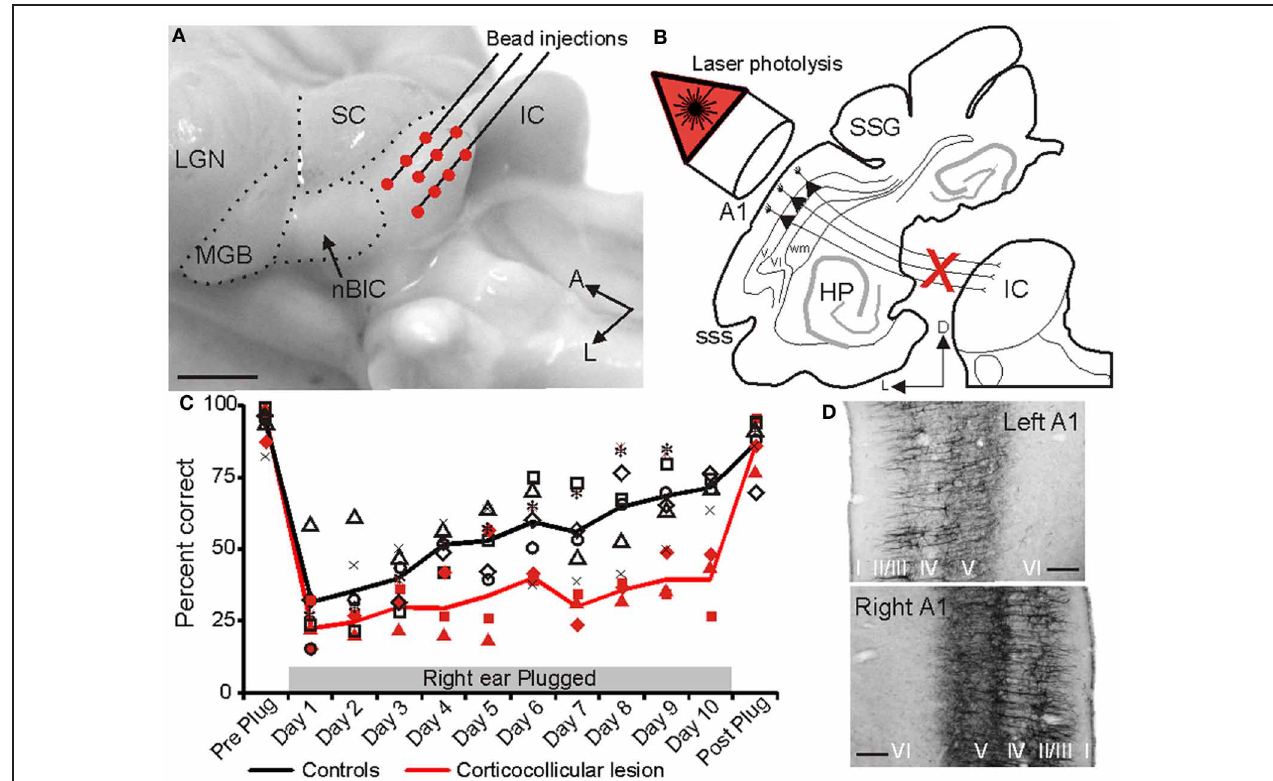
the 10 days over which an ear plug was worn and following its removal (Post-plug). Data from control animals are shown in black and from the ferrets with corticocollicular lesions in red. The symbols represent different animals and the lines show the mean scores. (D) Staining with the SMI 32 antibody, a marker of layer III and layer V pyramidal cortical neurons, was sparser in the left (lesioned) primary auditory cortex, resulting in a less distinct bilaminar appearance (top) than on the right side (bottom). Calibration bars: 2mm in (A) and 0.1mm in (D) . Modified with permission from Bajo et al.